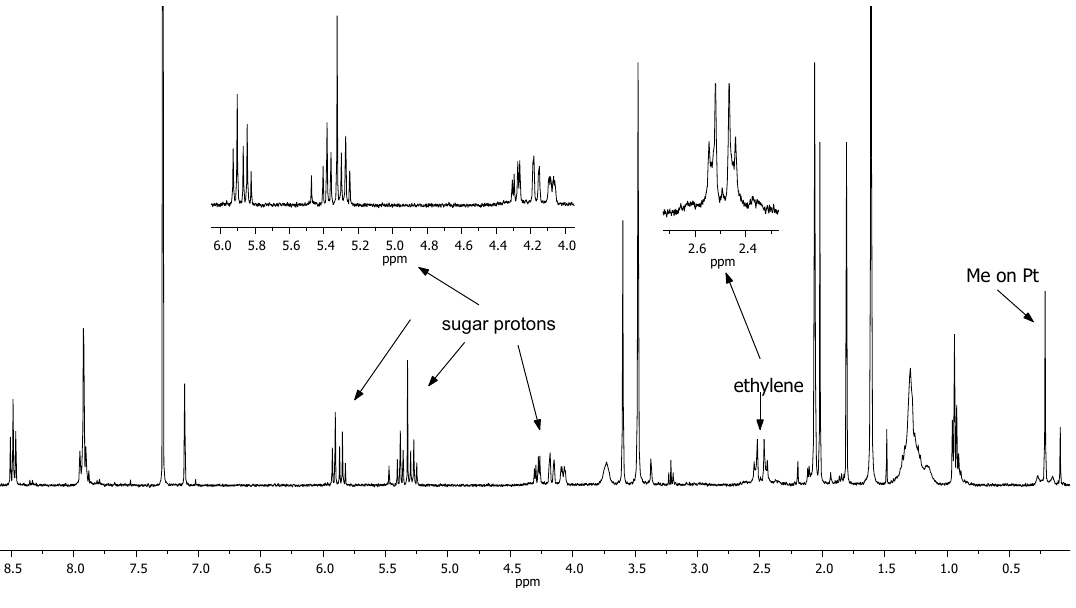
Figure 4. The 1 H NMR spectrum of 1 ‐ Me,Oct in CDCl 3 .